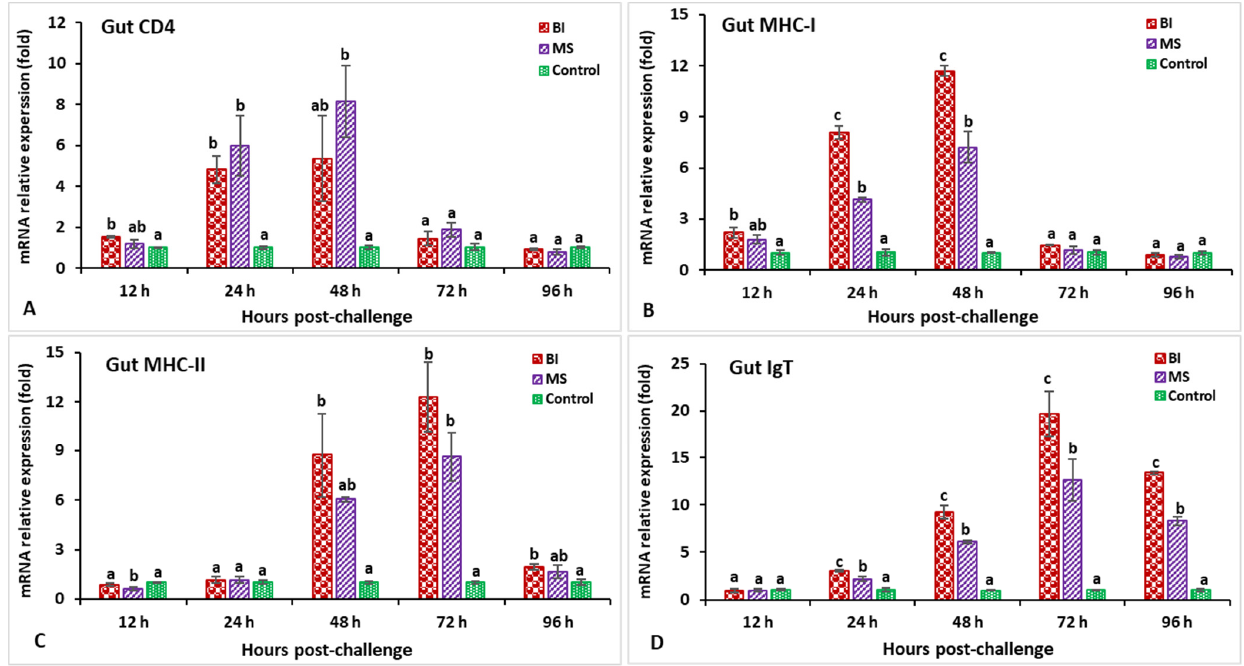
Figure 8. The gene expression of CD4 ( A ), MHC-I ( B ), MHC-II ( C ), and IgT ( D ) in the hindgut of orally vaccinated fish after being challenged by Streptococcus iniae (mean ± SE, n = 3). Dissimilar letters denote significant differences ( p < 0.05).